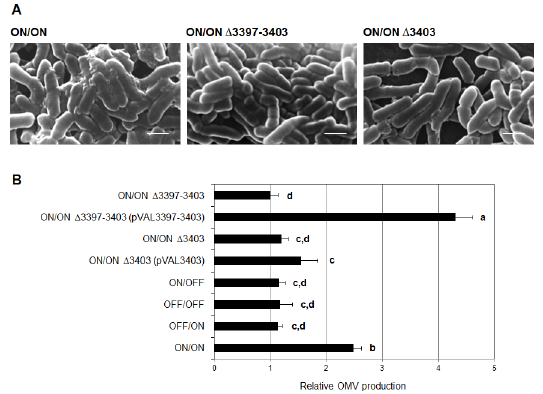
Fig 5. The role of IVp-II-regulated genes in B . fragilis OMV formation. (A) SEM was used to compare OMV formation. The IVp-II-regulated gene cluster was entirely ( Δ 3397 – 3403) or partially (only BF3403, the last gene of the cluster) deleted in the ON/ON genetic background of B . fragilis YCH46. Bar: 1 μ m. (B) Comparison of OMV production. OMV production was quantified by measuring the protein content of culture supernatants. The graph indicates OMV production relative to that of the ON/ON ( Δ 3397 – 3403) mutant. The data are expressed as means ± standard deviation. The bars labeled with different letters indicate significant differences at p <